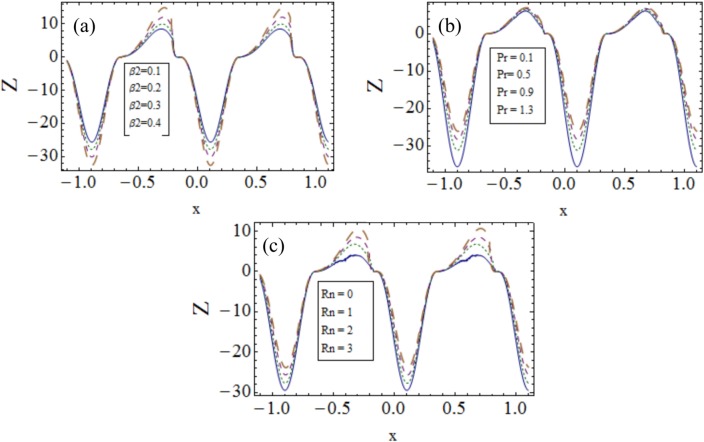
Influences of different parameters on heat transfer coefficient Z(x) when (a). ϵ = 0.2, t = 0.1, Rn = 2, Gr = 0.3, Qr = 1, λ1 = 1, Br = 0.5, Pr = 1, Nt = Nb = 1, M = 2, β1 = β3 = 0.1, E1 = 0.1, E3 = 0.01, E2 = 0.2. (b). ϵ = 0.2, t = 0.1, λ1 = 1, Rn = 2, Gr = 0.3, Qr = 1, Nt = Nb = 1, M = 2, β1 = β2 = β3 = 0.1, E1 = 0.1, E3 = 0.01, E2 = 0.2. (c). ϵ = 0.2, t = 0.1, Gr = 0.3, Qr = 1, Br = 0.4, Nt = Nb = 0.1, M = 2, β1 = β2 = β3 = 0.1, E1 = 0.1, E3 = 0.01, E2 = 0.2.